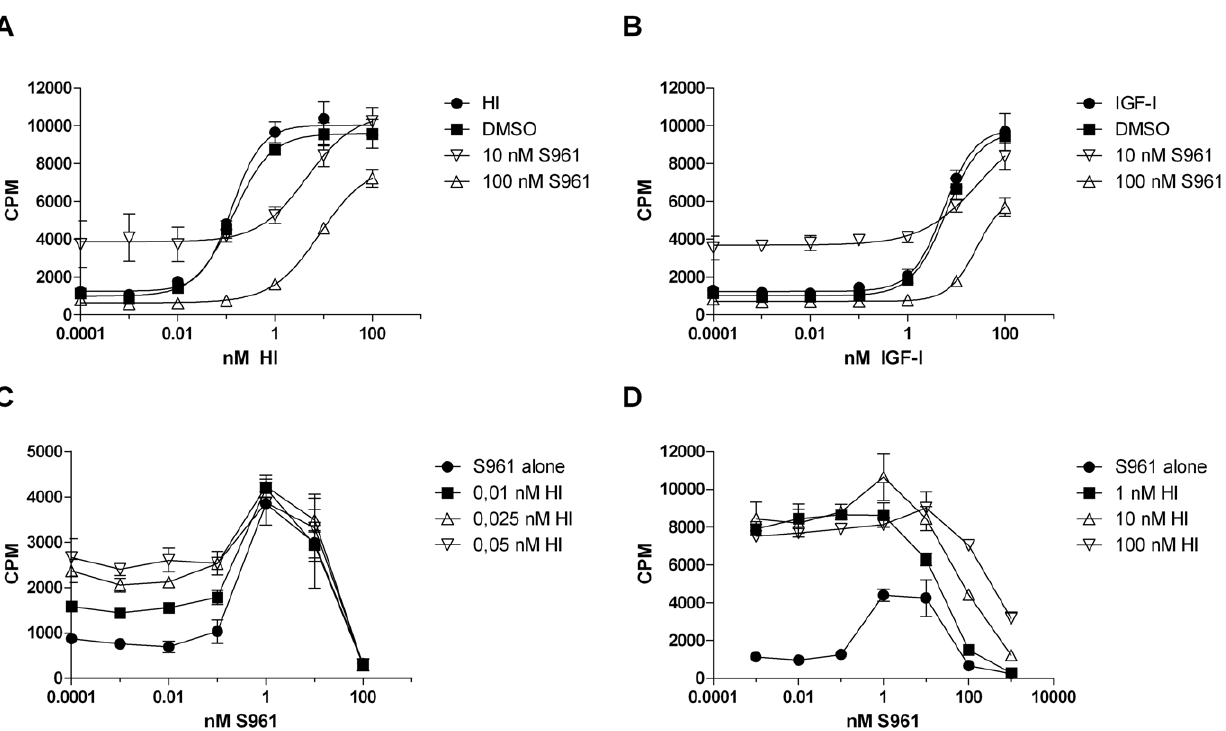
Figure 1. S961 has antagonist as well as agonist activity on IR-mediated mitogenic effect in L6-hIR cells. A, "10 nM S961" and "100 nM S961" curves: Cells were pretreated for 2h with 10 nM or 100 nM S961, and stimulated with increasing concentrations of insulin (as indicated on the x-axis) in the continued presence of S961. "HI" curve, insulin stimulation only (without S961). "DMSO" curve, insulin stimulation with equal volume DMSO added instead of S961. B, "10 nM S961" and "100 nM S961" curves: Cells were pretreated for 2h with 10 nM or 100 nM S961, and stimulated with increasing concentrations of IGF-I (as indicated on the x-axis) in the continued presence of S961. "IGF-I" curve, IGF-I stimulation only (without S961). "DMSO" curve, IGF-I stimulation with equal volume DMSO added instead of S961. C, "0.01 nM HI", "0.025 nM HI" and "0.05 nM HI" curves: Cells were pretreated for 2 h with increasing concentrations of S961 (as indicated on the x-axis), and stimulated with 0.01 nM, 0.025 nM or 0.05 nM HI in the continued presence of S961. "S961 alone" curve, insulin was omitted. D , "1 nM HI", "10 nM HI" and "100 nM HI" curves: Cells were pretreated for 2 h with increasing concentrations of S961 (as indicated on the x-axis), and stimulated with 1 nM, 10 nM or 100 nM HI in the continued presence of S961. "S961 alone" curve, insulin was omitted. A and B, Graphs are representative for three independent experiments, each experiment comprising triplicate determinations of each ligand concentration. C, The graph is performed in triplicates once. D, The graph is representative for two independent experiments each performed in triplicates. Error bars indicate one standard deviation.